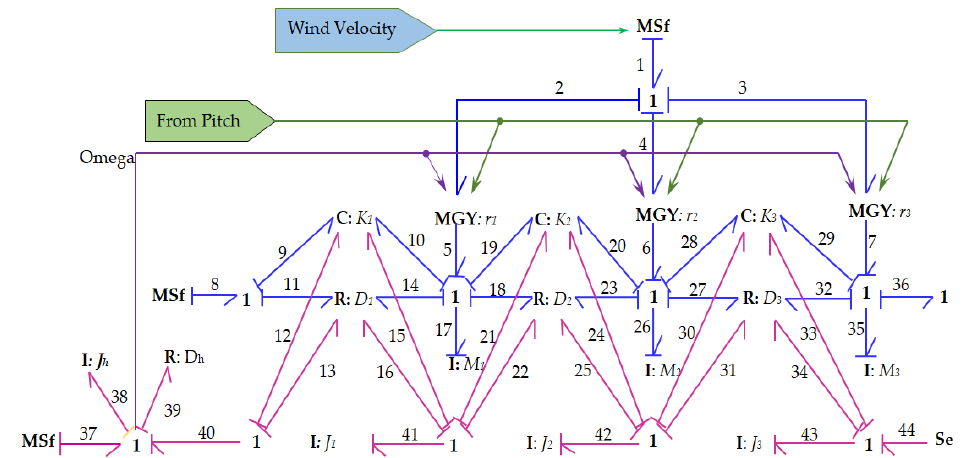
Figure 5. Overall bond graph modeling of wind turbine blade with subjected loads. The bond graph elements are sequentially numbered (1–44).